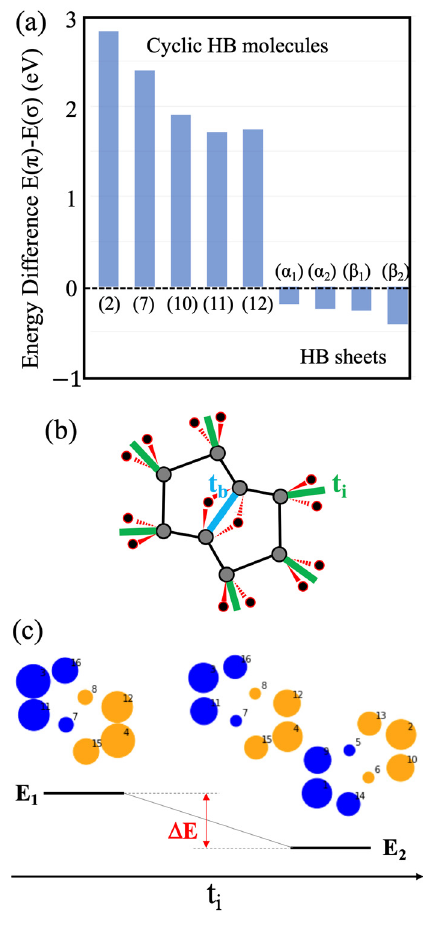
Figure 5. ( a ) Energy differences E( π ) − E( σ ) between boron materials, corresponding to the HOMO-LUMO gap (gap between lower-band and higher band of DNL at Г point) for the HB molecules (the HB sheets). Molecules: (2) 2:3:5:6:-H-1,4:1,4- μ H-B 6 H 6 , (7) 2:3:4:6:7:8:-H-1,5:1,5- μ H-B 8 H 8 , (10) and Table 1. Sheets (at Г point): ( α 1 ) α 1 -borophane, ( α 2 ) α 2 -borophane, ( β 1 ) β 1 -borophane, ( β 2 ) β 2 -borophane. ( b ) Descriptions of the tight-binding parameters t b and t i . ( c ) Energy diagram calculated from the tight-binding model with wave function forms before and after the interaction. Only one of the neighboring molecular orbitals is shown for the case t i /t s = 0.1 for comparison with the results in Figure 4a.